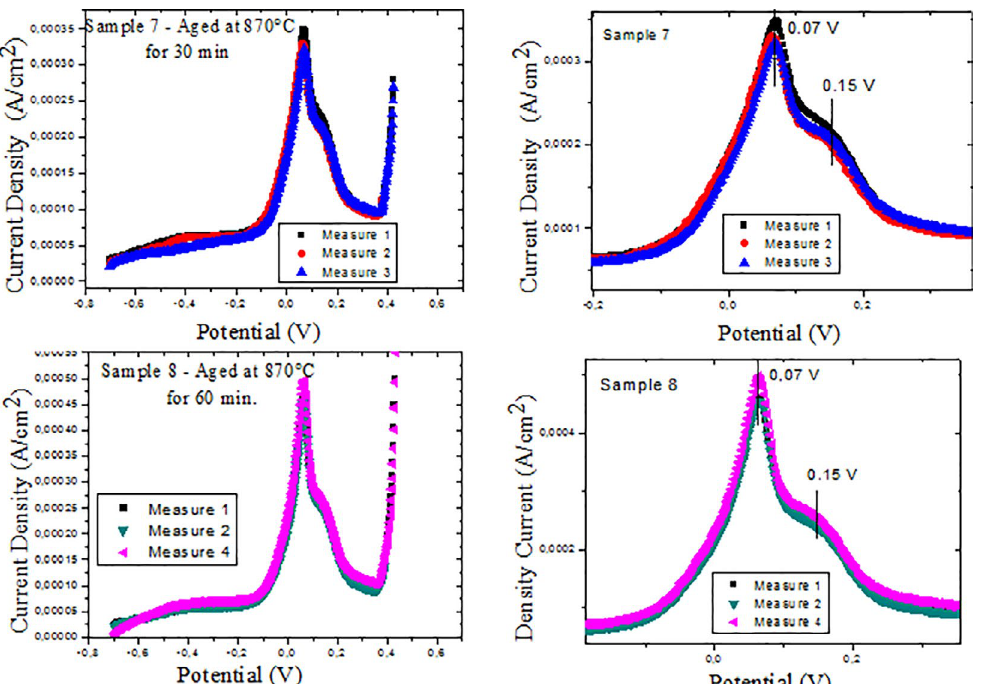
Figure 8. Linear Sweep Voltammetry of steel UNS S31803 for different heat treatment conditions in 3 mol /L KOH solution and 2 mV/s scan rate.